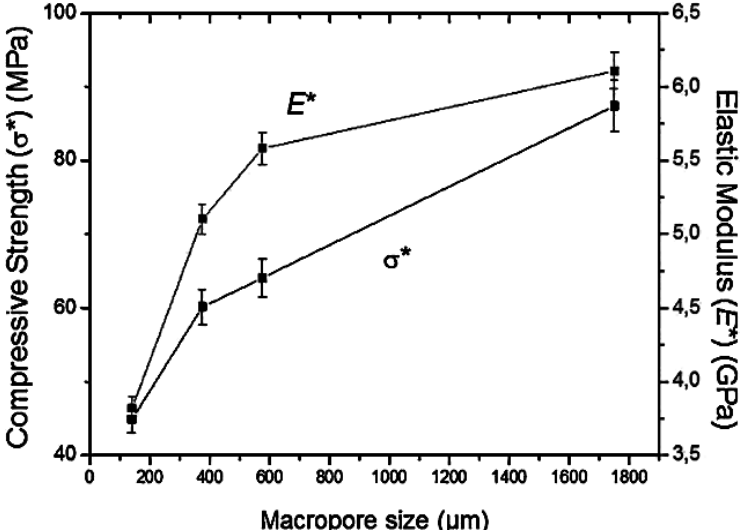
Figure 15. Compressive strength and elastic modulus variation with varying macropore size in porous titanium material with 64% porosity [200]. Reprinted with permission from [200]. Copyright 2011